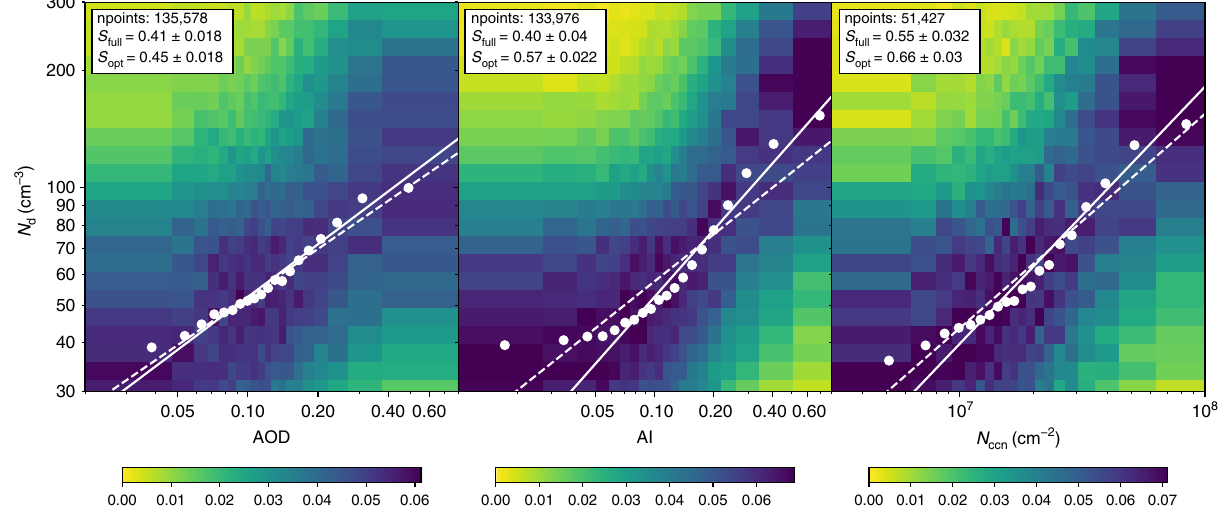
) versus aerosol optical depth (AOD), d ), for the global ocean data set for 2006. Each point represents a bin median ccn in each AOD/ d 10 7 cm (cid:1) 2 , AI > 0.05, and ccn >